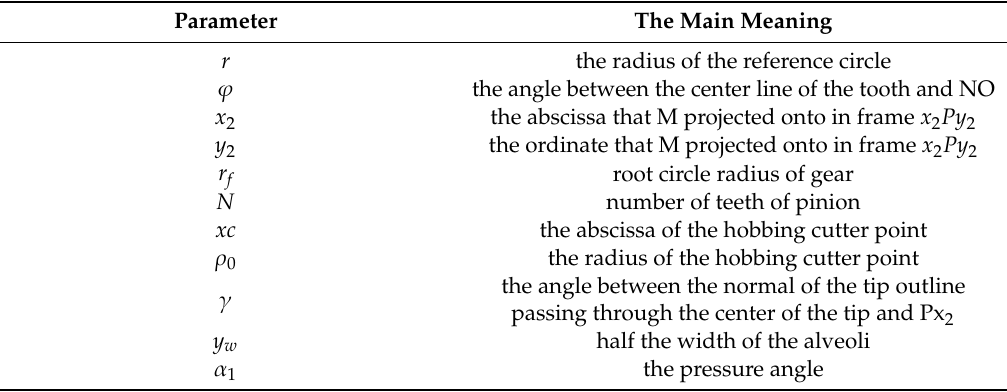
Table 1. The meaning of each parameter of the gear tooth profile. Parameter The Main Meaning